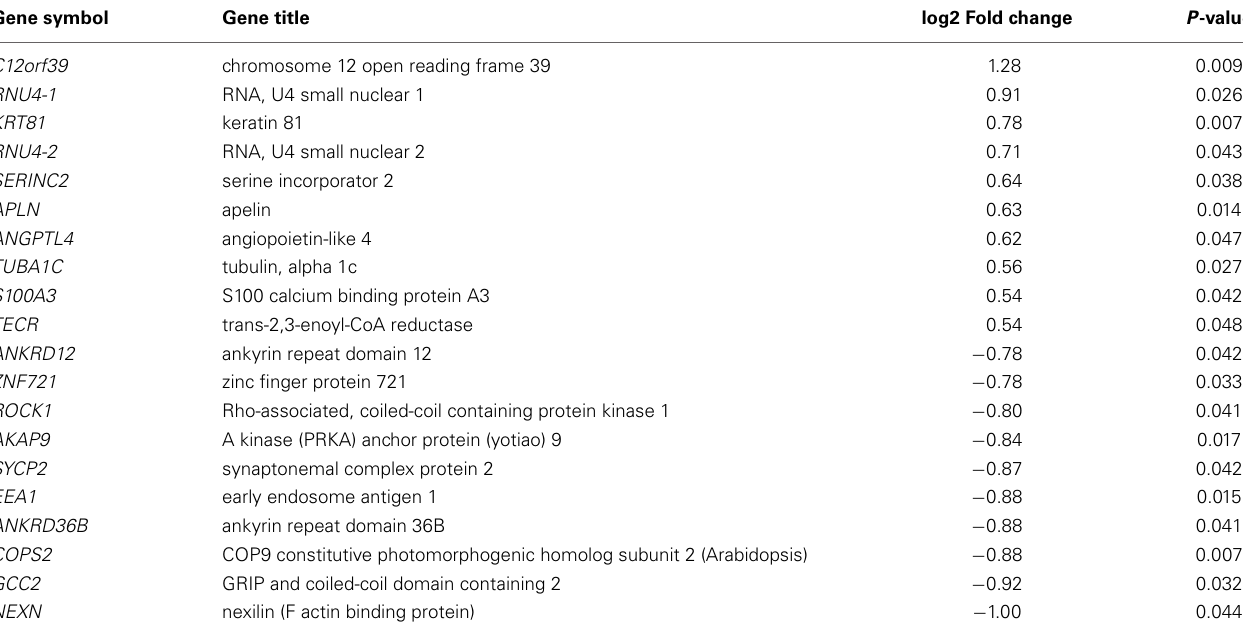
Table 8 | Significantly up- and down-regulated top molecules in the control vs. SSRI group (- = reduction in expression levels). Gene symbol